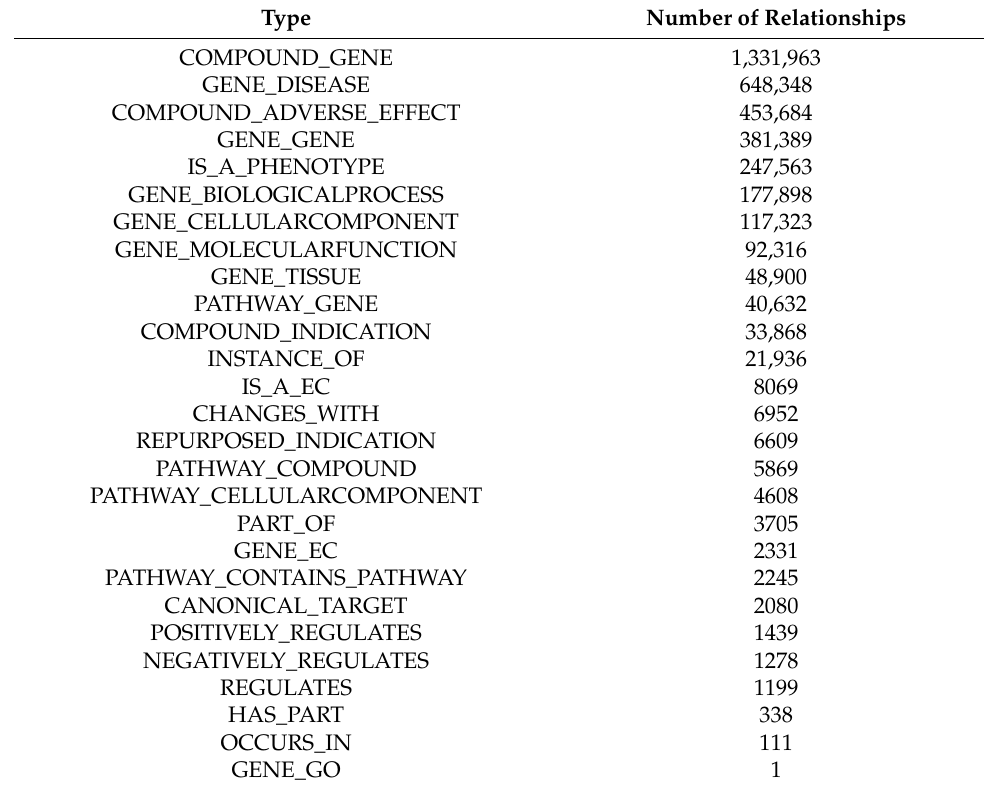
Table 2. Descriptive statistics of relationships extracted from